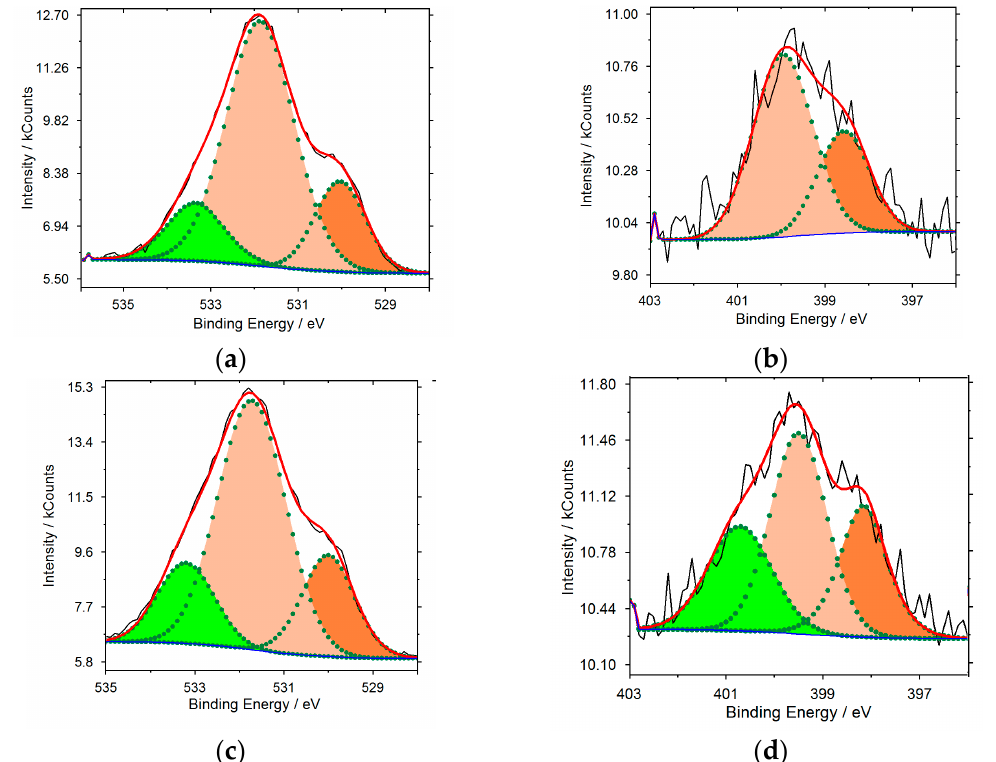
Figure 1. O1s ( a , c ) and N1s ( b , d ) X-ray spectra recorded on CNT-2 ( a , b ) and on CNT-4 ( c , d ). For CNT-1 and CNT-3, the surface values determined by the BET and MSP using octane are similar are close. It should be noted that the hydrophilic surface is significantly larger in nanotubes treated with nitric acid. One possible reason is the large number